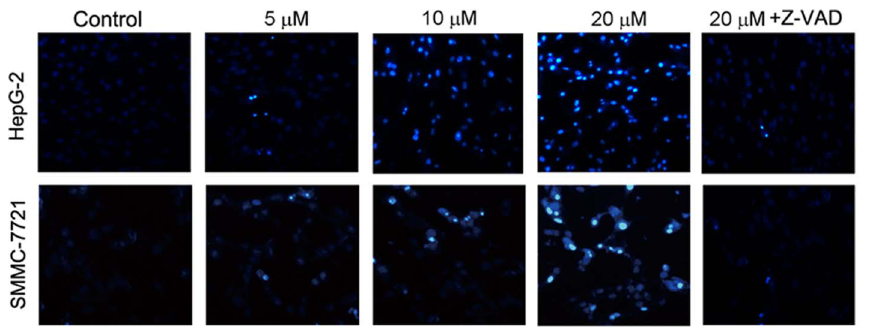
Fig. 3. Nuclear morphology of HepG2 and SMMC7721 cells treated with 5, 10, and 20 m M abieslactone or 20 m M Z-VAD-FMK for 24 h was determined by staining with Hoechst 33258.